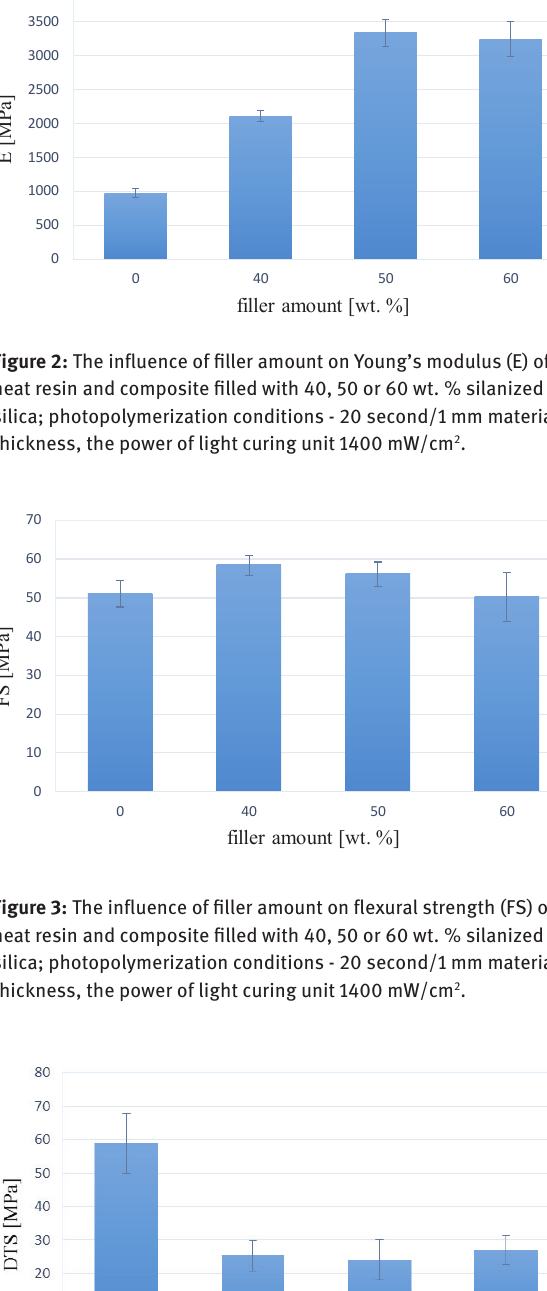
Figure 4: The influence of filler amount on diametral tensile strength (DTS) of neat resin and composite filled with 40, 50 or 60 wt. % silanized silica; photopolymerization conditions - 20 second/1 mm material thickness, the power of light curing unit 1400 mW/cm 2 .